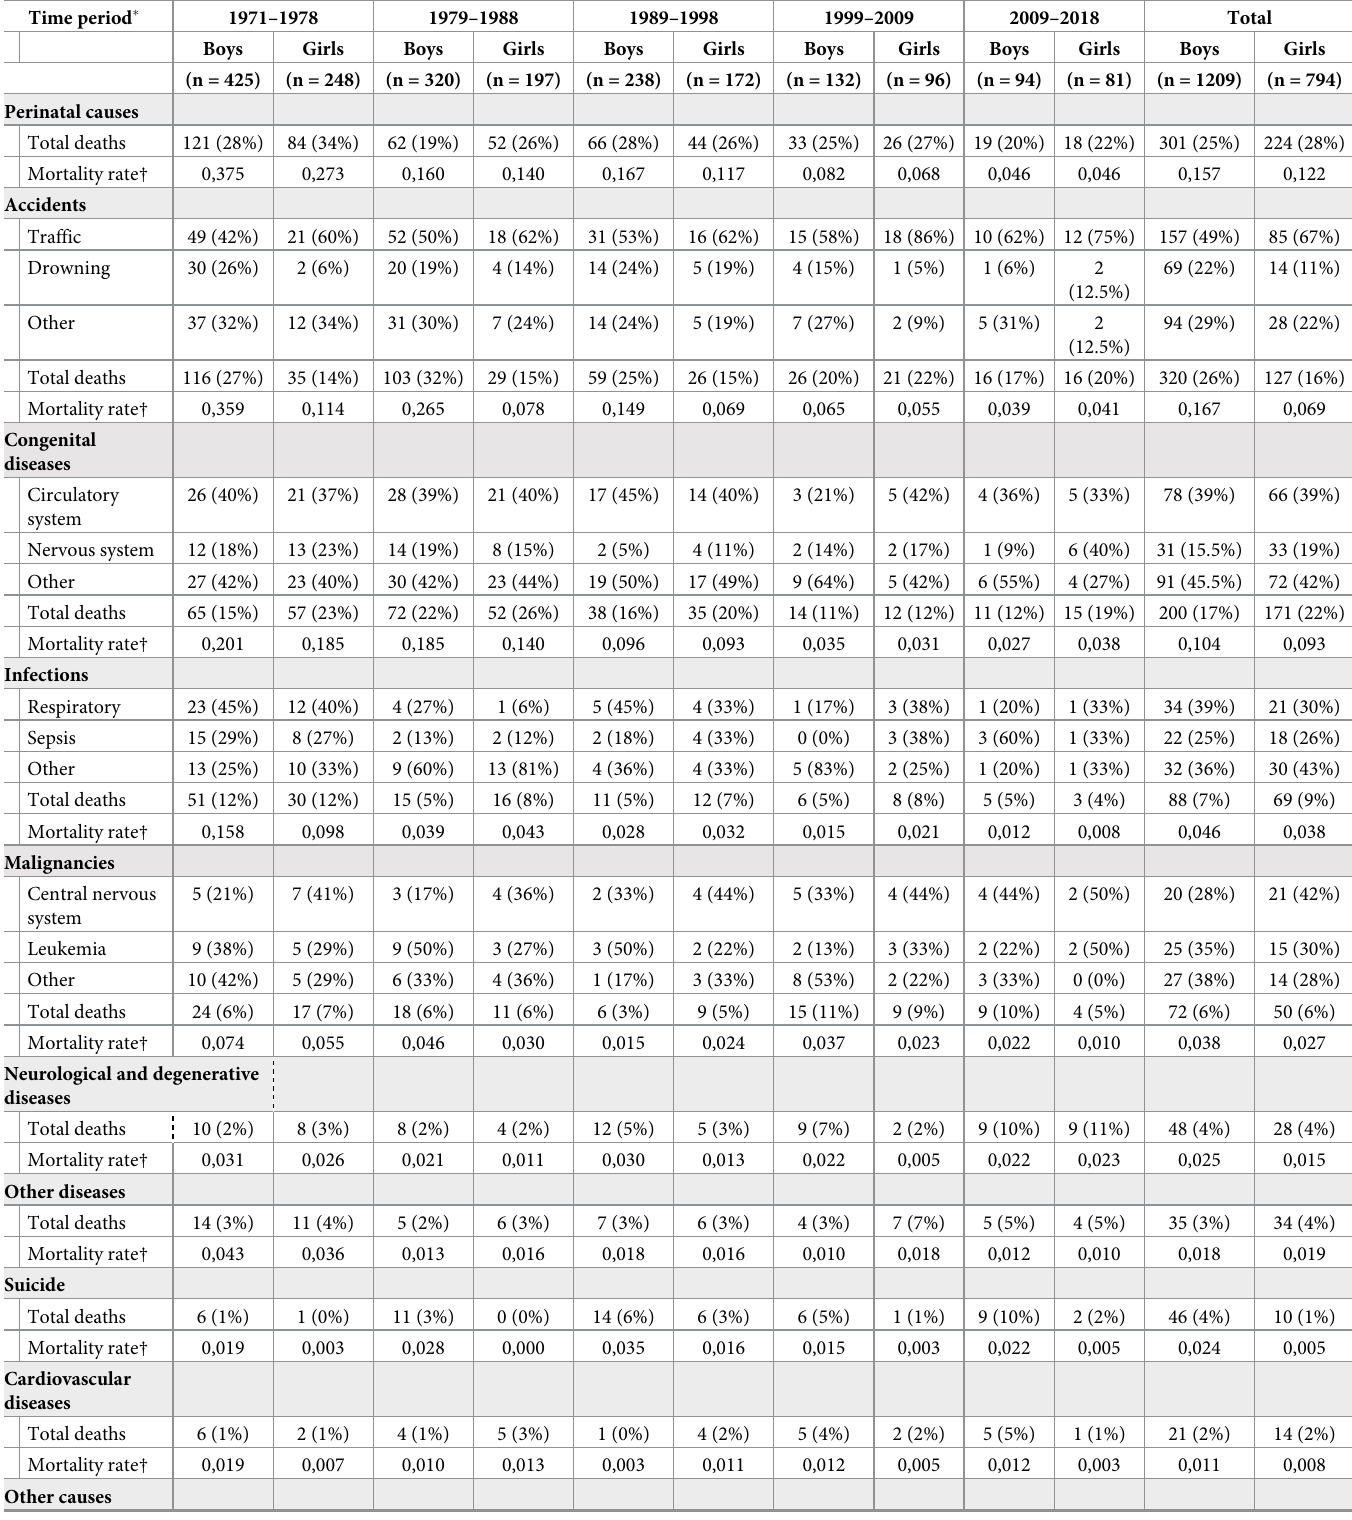
Table 1. Causes of death in Icelandic children according to disease categories, gender and time periods from January 1 st , 1971 until December 31 st 2018. Time period